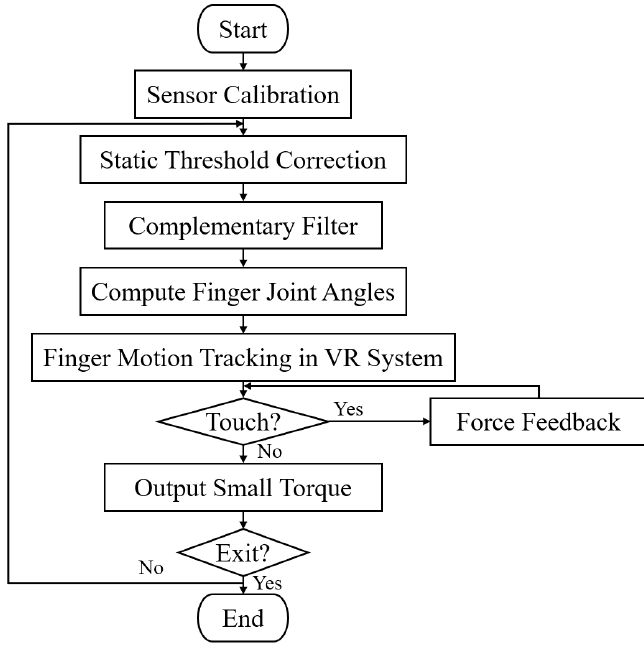
Figure 4. Execution flowchart of software program for the VR hand training